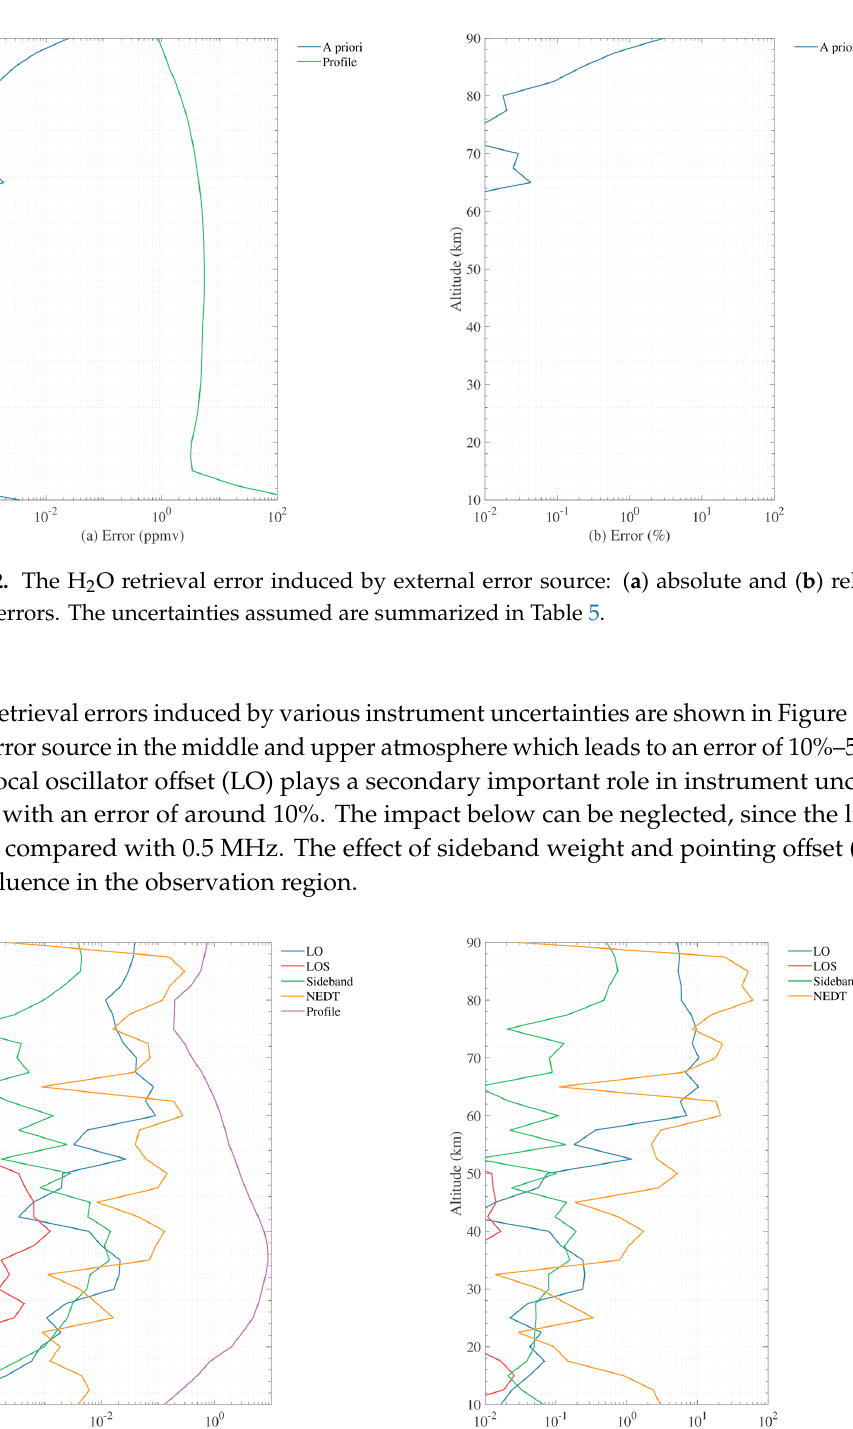
Figure 13. The O 3 retrieval errors induced by different instrument uncertainty sources: ( a ) absolute and ( b ) relative retrieval errors. The uncertainties assumed are summarized in Table 3.